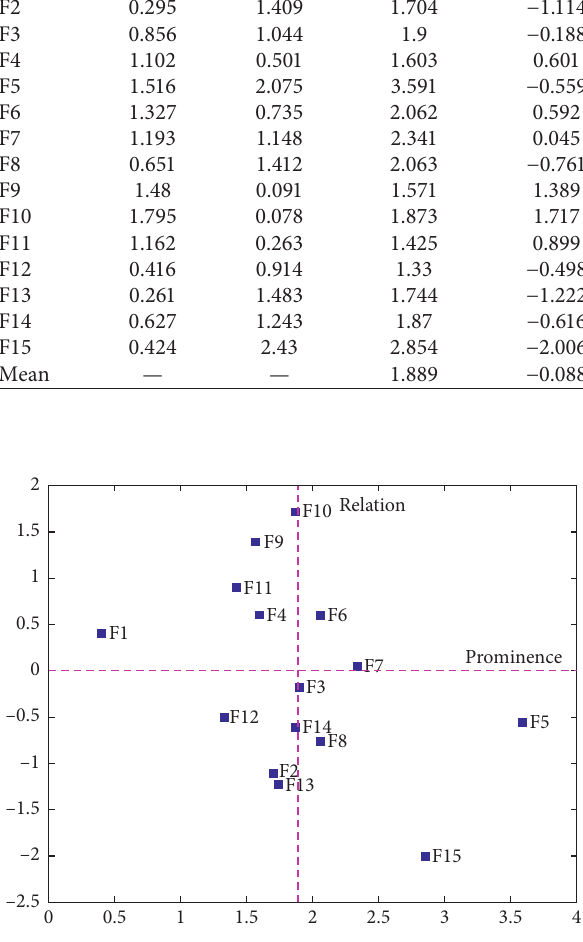
Figure 1: The interactive influence between the 15 criteria.